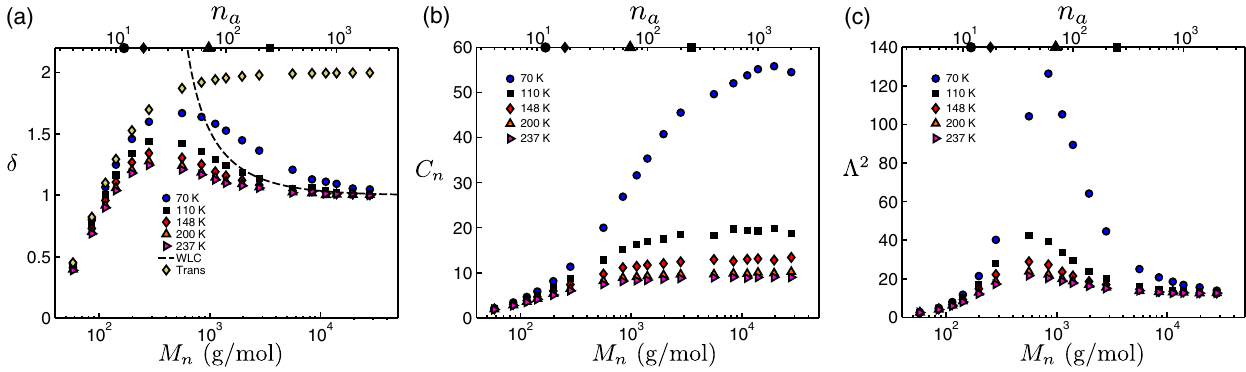
; Λ 2 for PE at different temperatures. Panel (a) also includes calculations for the all-trans state n l 1 . 54 nm, corresponding to T ¼ 298 K. = 2 , with Kuhn step l p ¼ K K ¼